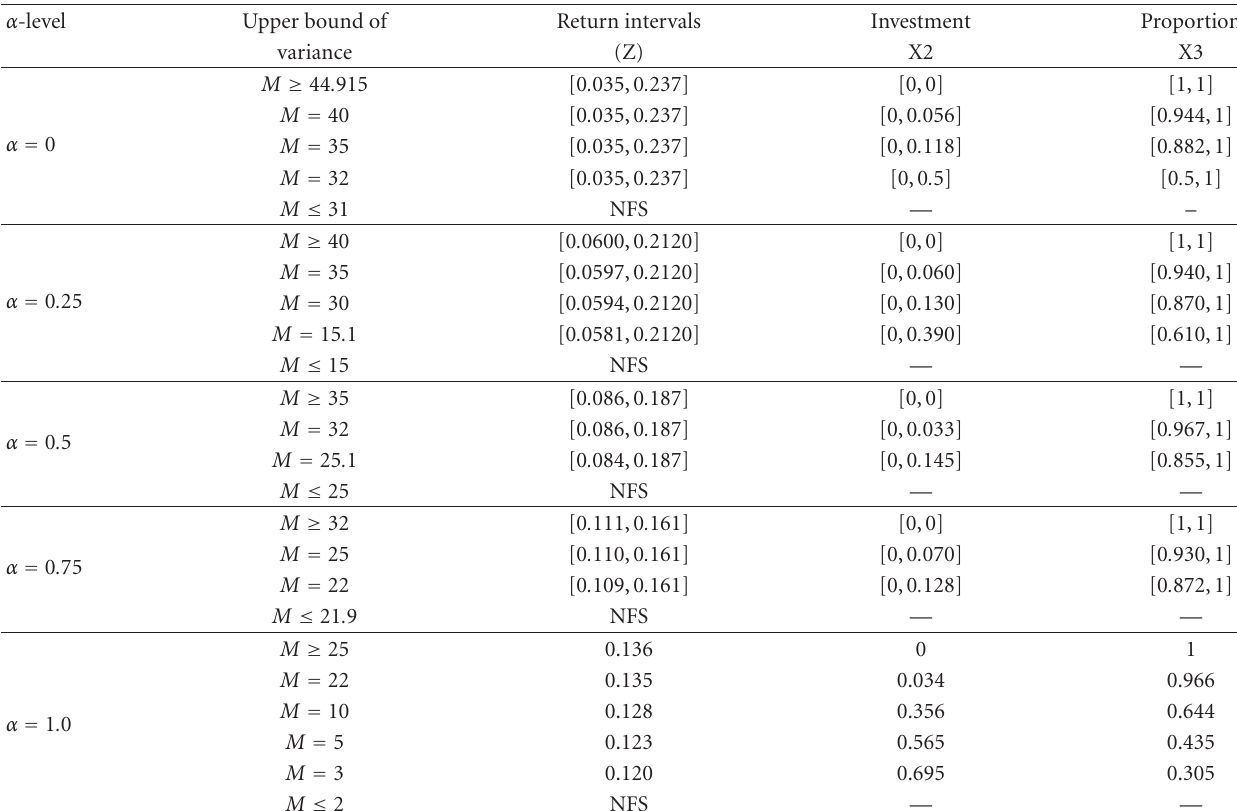
Table 3: Investment proportions with di ff erent levels of α for maximizing